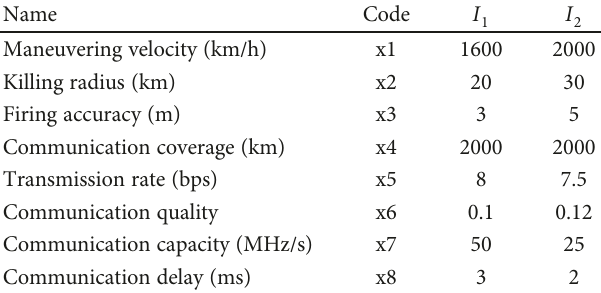
Table 4: Tactical indexes of I